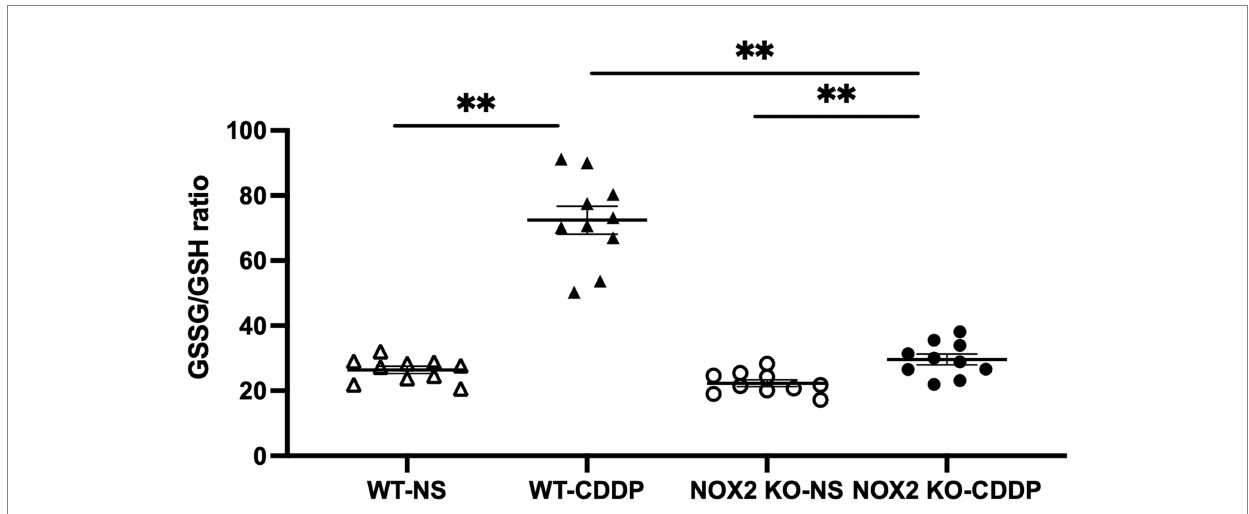
FIGURE 2 NOX2-KO mice markedly attenuate the cisplatin-induced ROS increase in WT mice. The glutathione disulfide/glutathione ratio, an indicator of oxidative stress, was increased 3 days after cisplatin injection in the WT group. In contrast, ROS were a significantly blunt in the NOX2-KO CDDP group compared with the WT-CDDP group. Data represent the mean ± standard error of five mice per group. The experiment was repeated twice with similar